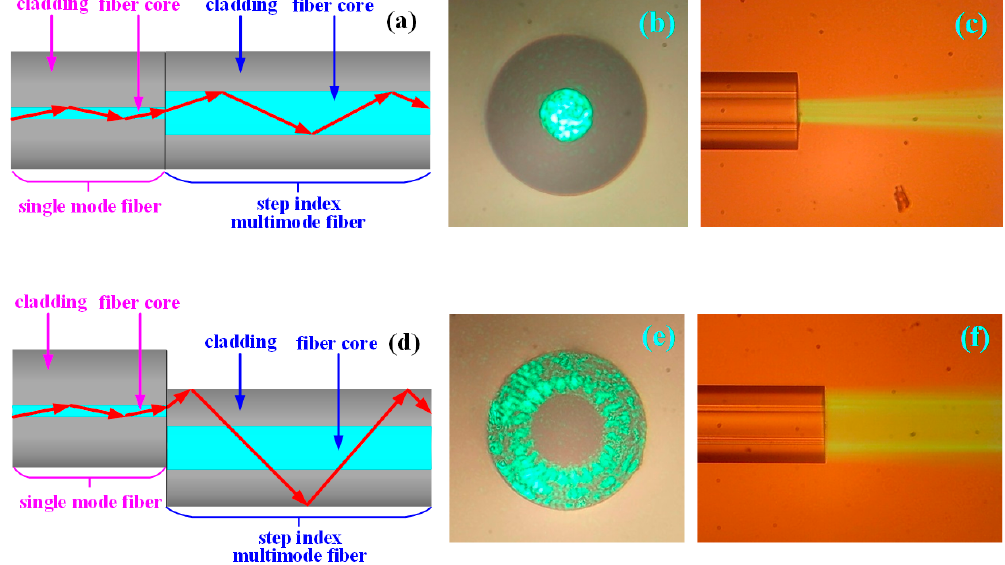
Figure 3. The investigation of the transmission of the light field of the step refractive index multimode fiber when normalized core welding and core-shift welding are used. ( a ) The schematic diagram of the structure and light transmission of the step refractive index multimode fiber when normalized welding is used. ( b ) Microphotograph of the light field from the end face of the step refractive index multimode fiber when normalized core welding is used. ( c ) Microphotograph of the light field from the side face of the step refractive index multimode fiber when normalized core welding issued. ( d ) The schematic diagram of the step refractive index multimode fiber structure and light transmission when core-shift welding is used. ( e ) Microphotograph of the light field from the end face of the step refractive index multimode fiber when core-shift welding is used. ( f ) Microphotograph of the light field from the side face of the step refractive index multimode fiber when core-shift welding is used.